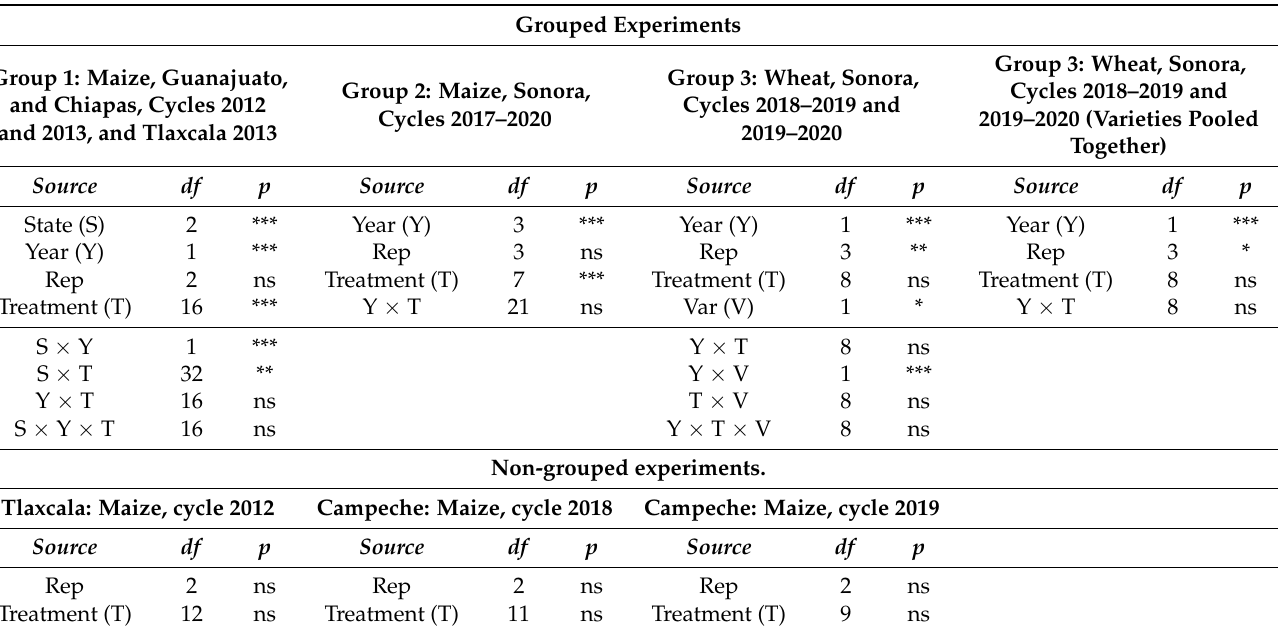
Table 7. ANOVA’s of experiments conducted in five Mexican states to test the effectiveness of partially substituting synthetic fertilizers by